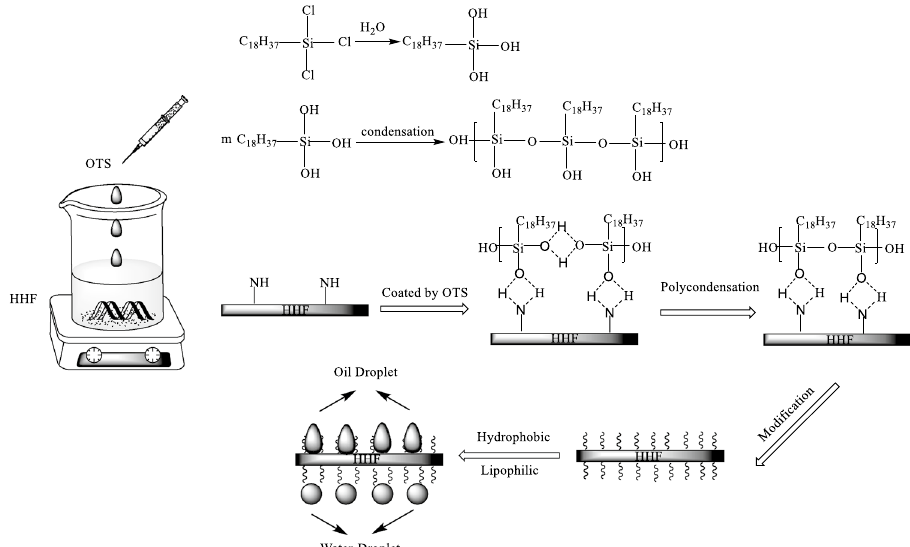
Scheme 1. Schematic illustration of the formation mechanism of the PODS and modified human hair